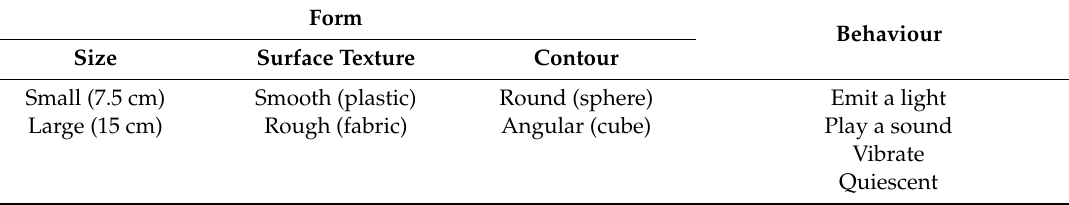
Figure 1. Picture of interactive objects (IOs) and the motion sensor. Table 1. Variables with corresponding levels.